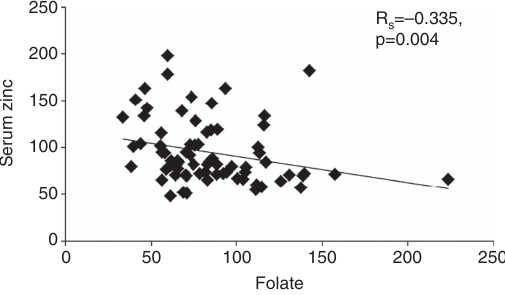
Figure 2 Correlation between erythrocyte folate and serum zinc